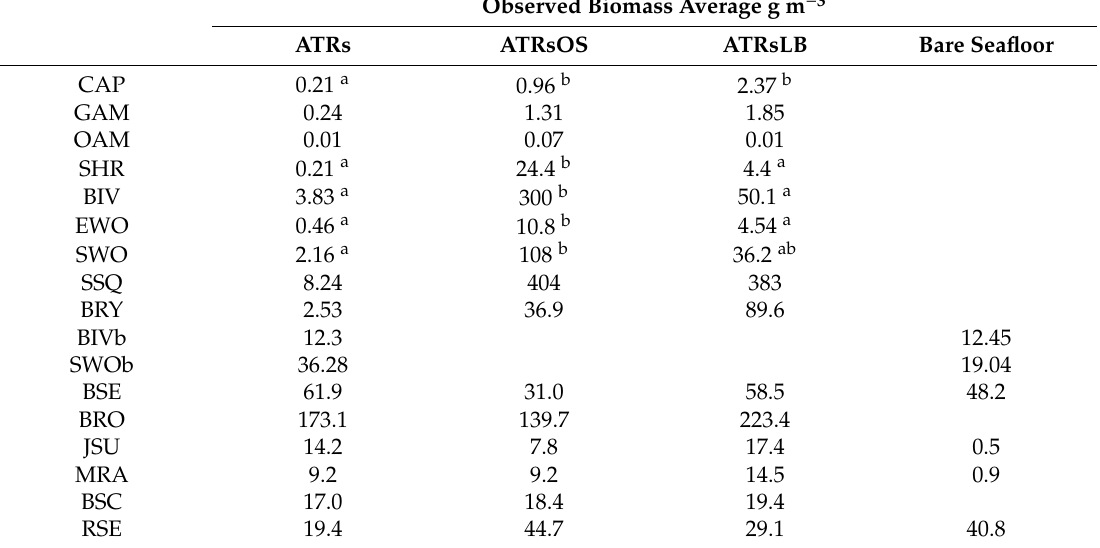
Figure 3. Relative temporal changes in attached organisms on simple artificial timber reefs and those with either supplementary oyster shells or supplementary leaf and branch materials.